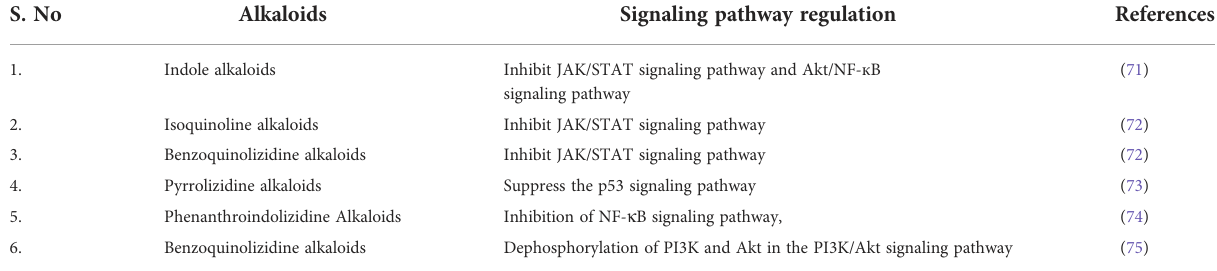
TABLE 2 Molecular action and signaling pathway regulation of alkaloids. S.